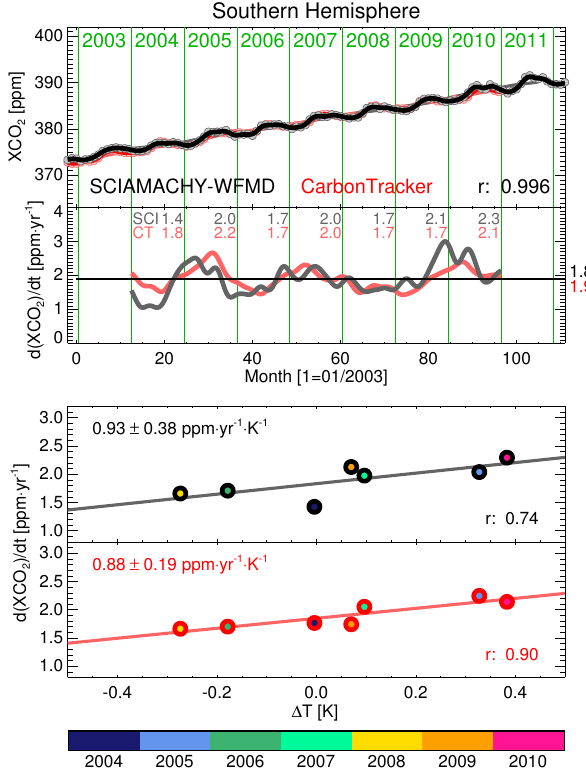
Fig. 4. As Fig. 3 but for the Southern Hemisphere and Southern Hemisphere growing season (December–May) surface temperature